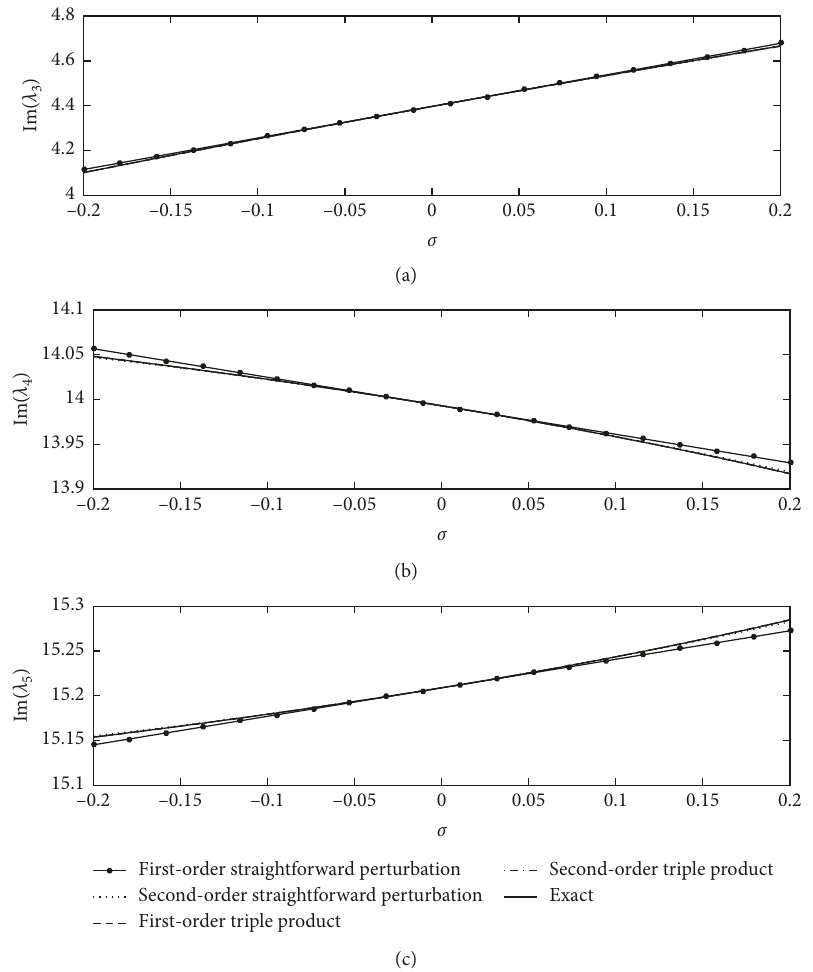
Figure 13: The imaginary parts of the exact and approximate eigenvalues of the whirling beam as a function of σ .